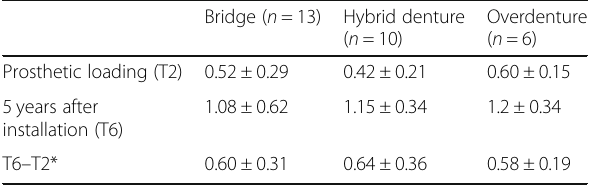
Table 5 MBL of each prosthesis group at prosthetic loading and 5 year after implant installation Bridge ( n = 13) Hybrid denture ( n =